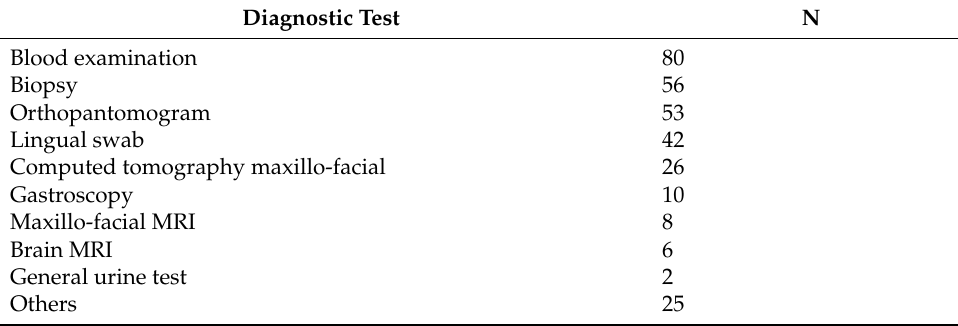
Table 2. Diagnostic tests ordered by referring providers.